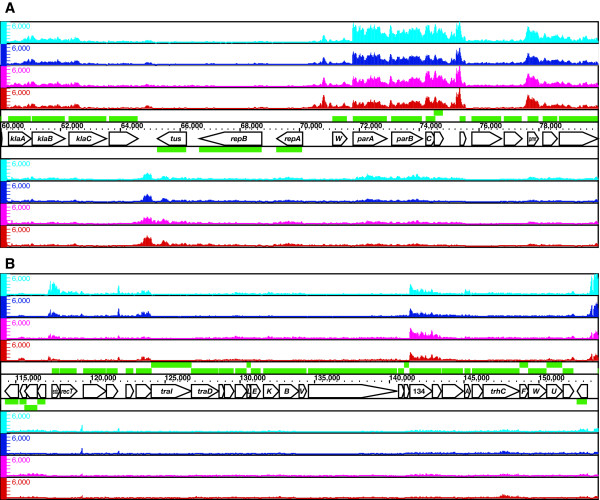
High-resolution mapping of the IncP-7 plasmid backbone, rep and par (A) and tra (B). Single-stranded cDNA from KT2440(pCAR1) grown on succinate (cyan) or carbazole (blue) and from CA10 grown on succinate (magenta) or carbazole (red) was mapped on both strands of pCAR1, which are transcribed from left to right (above) and from right to left (below). Pentagons represent the pCAR1 genes and their transcriptional directions; the gene names or ORF numbers are indicated therein. The scale bars indicate the signal intensities from 0 to 6,000 on a linear scale.